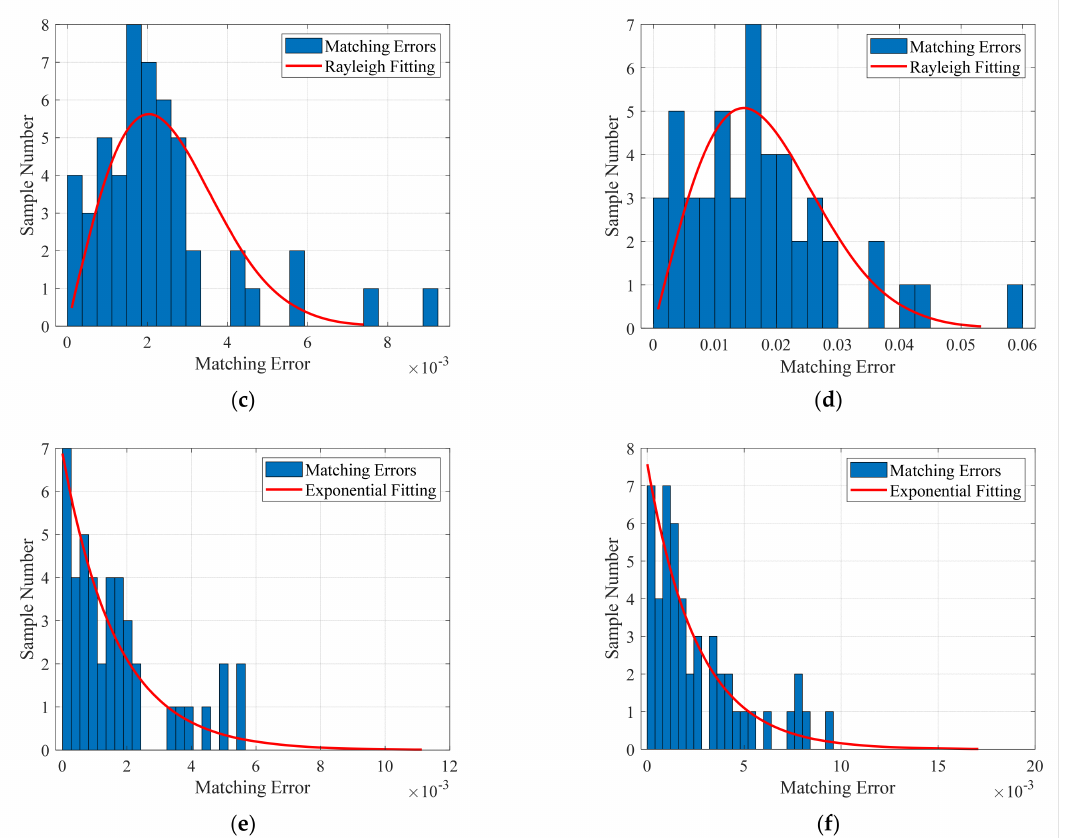
Figure 5. ( a ) The matching error matrix corresponding to the coastal waveforms of experimental area 1 in March. ( b ) The median errors at all gates in different months for experimental area 1. ( c , d ) Two typical error histograms fit by the Rayleigh distribution. ( e , f ) Two typical error histograms fit by exponential